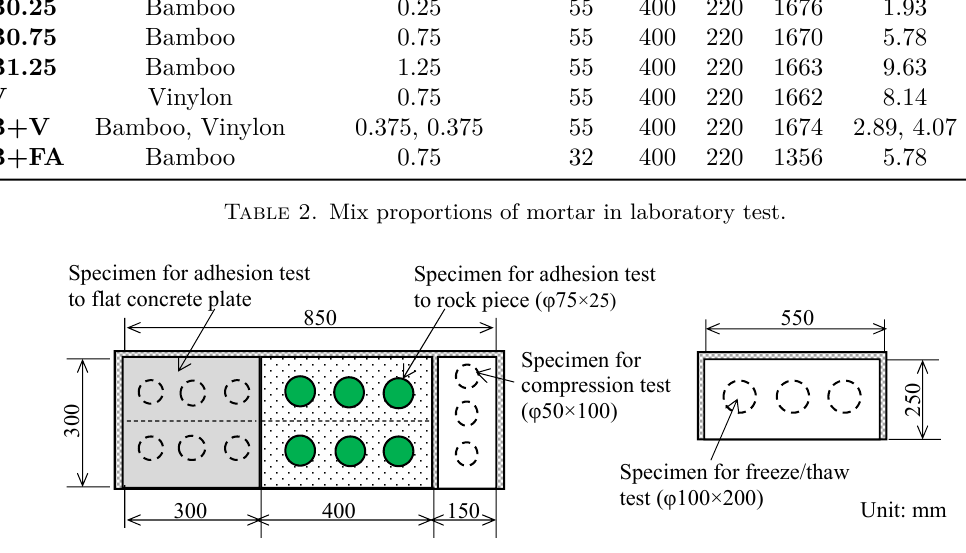
Figure 1. Top view of formworks for spraying and sampling of